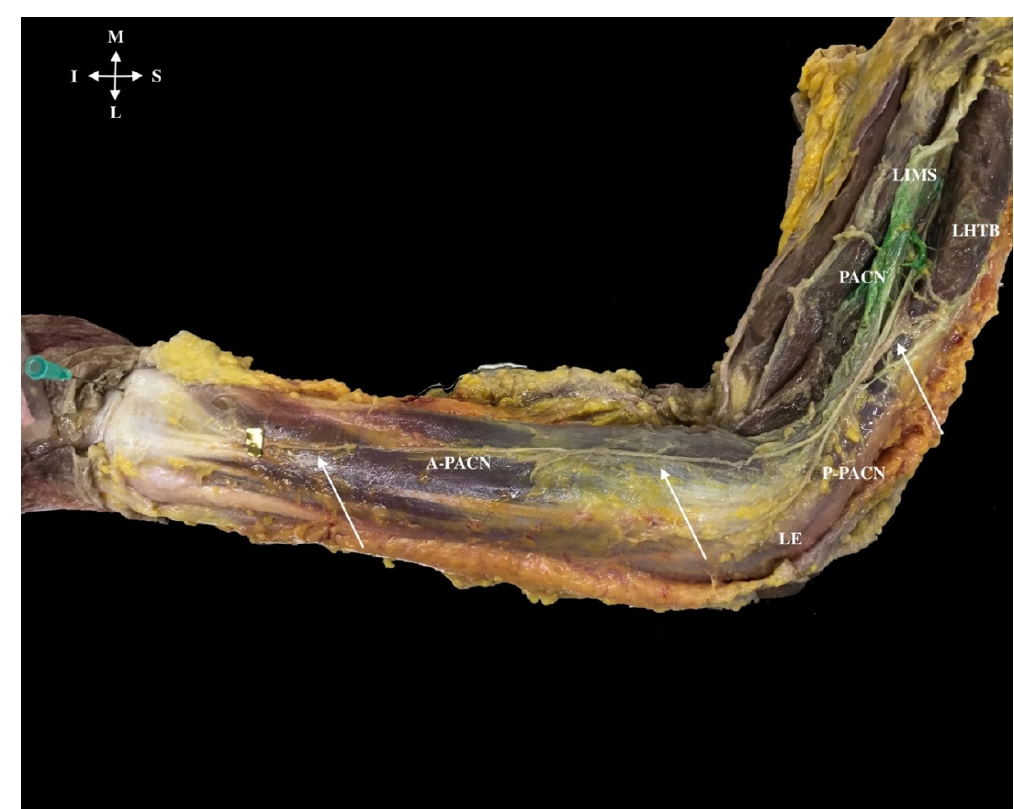
Figure 8. Pathway of the posterior antebrachial cutaneous nerve (PACN) (superior white arrow) after crossing the deep fascia of the arm (green dye). Posterior division into two branches anterior (A-PACN) (inferior white arrows) and posterior (P-PACN) was always anterior to the lateral epicondyle (LE). The needle landmarks the wrist. Lateral intermuscular septum (LIMS), lateral head triceps brachii muscle (LHTB).